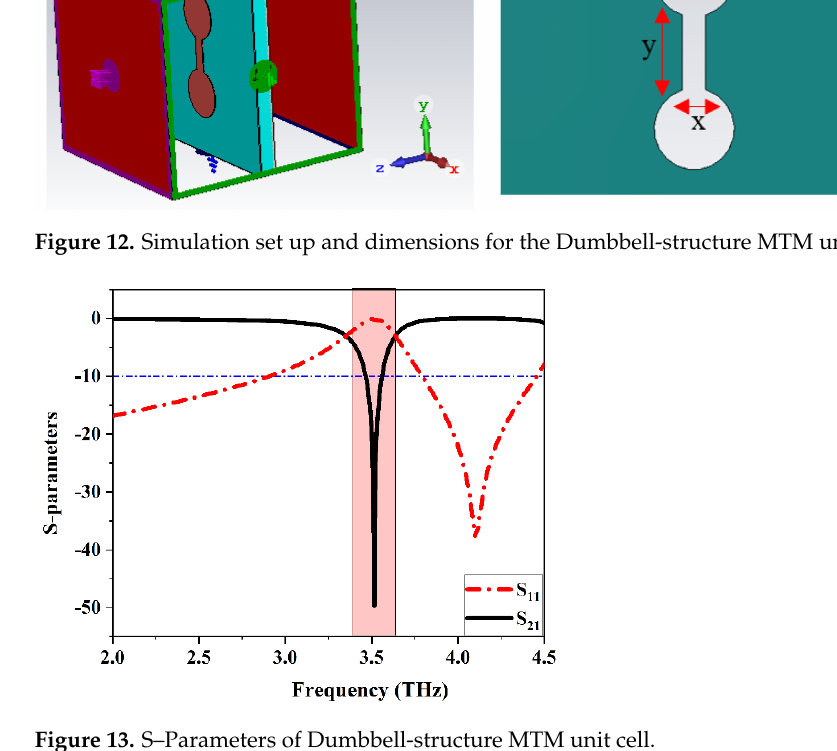
Figure 13. S − Parameters of Dumbbell-structure MTM unit cell. Figure 13. S–Parameters of Dumbbell-structure MTM unit